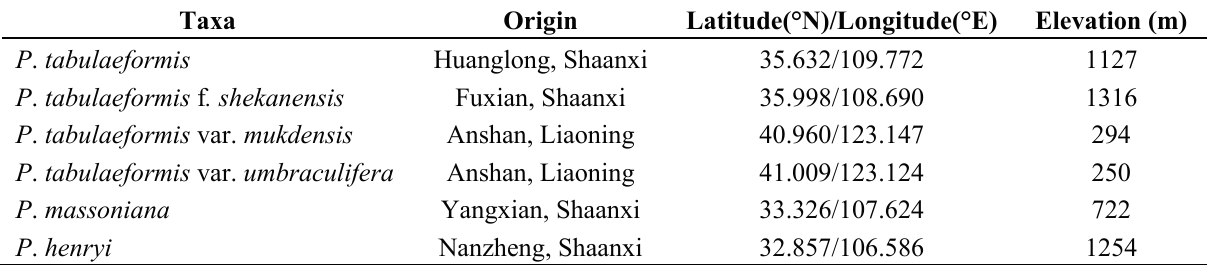
Table 4. The origins of the six Pinus taxa with their geographical